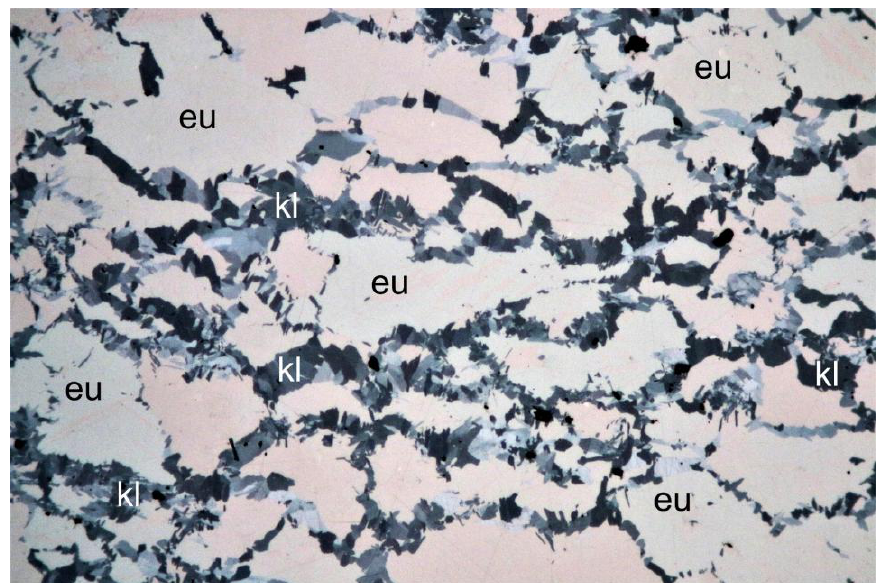
Figure 11. Detail from Se vein Type-1: Flattening of granularly textured eucairite (eu) showing a network of extensional fractures outlined by klockmannite (kl). Subsequent compression created multiple kinkbands in the klockmannite, which were later modified by recrystallization. Reflected light image, 500-μm-wide, plane polarized light.